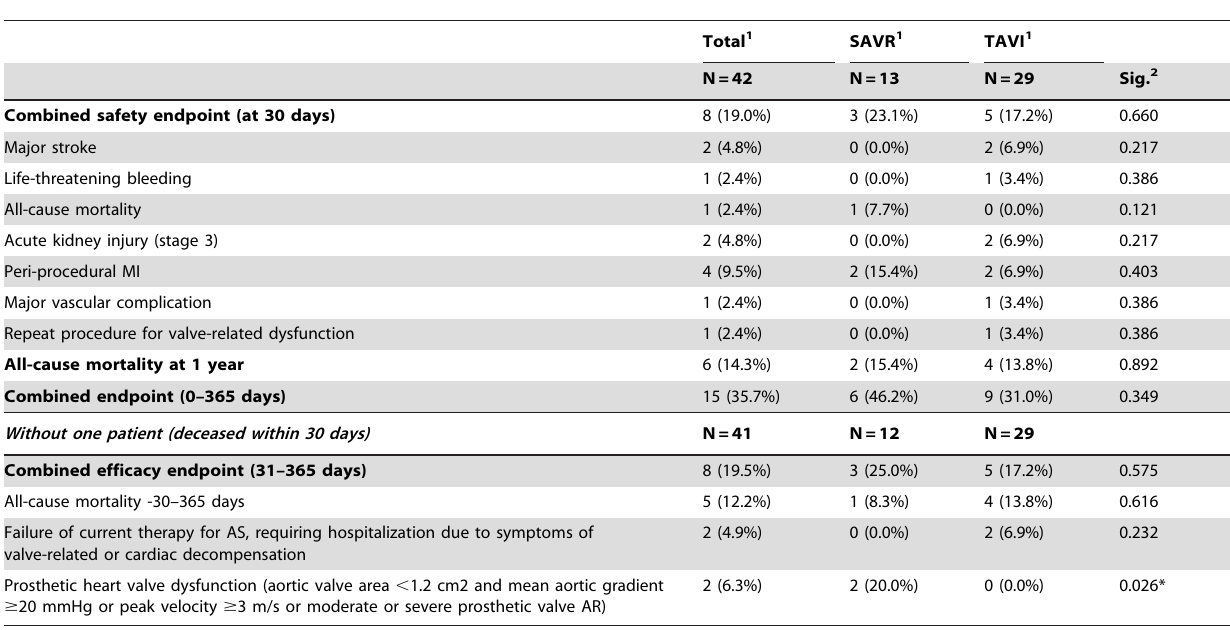
Table 3. Occurrence of endpoints in SAVR and TAVI